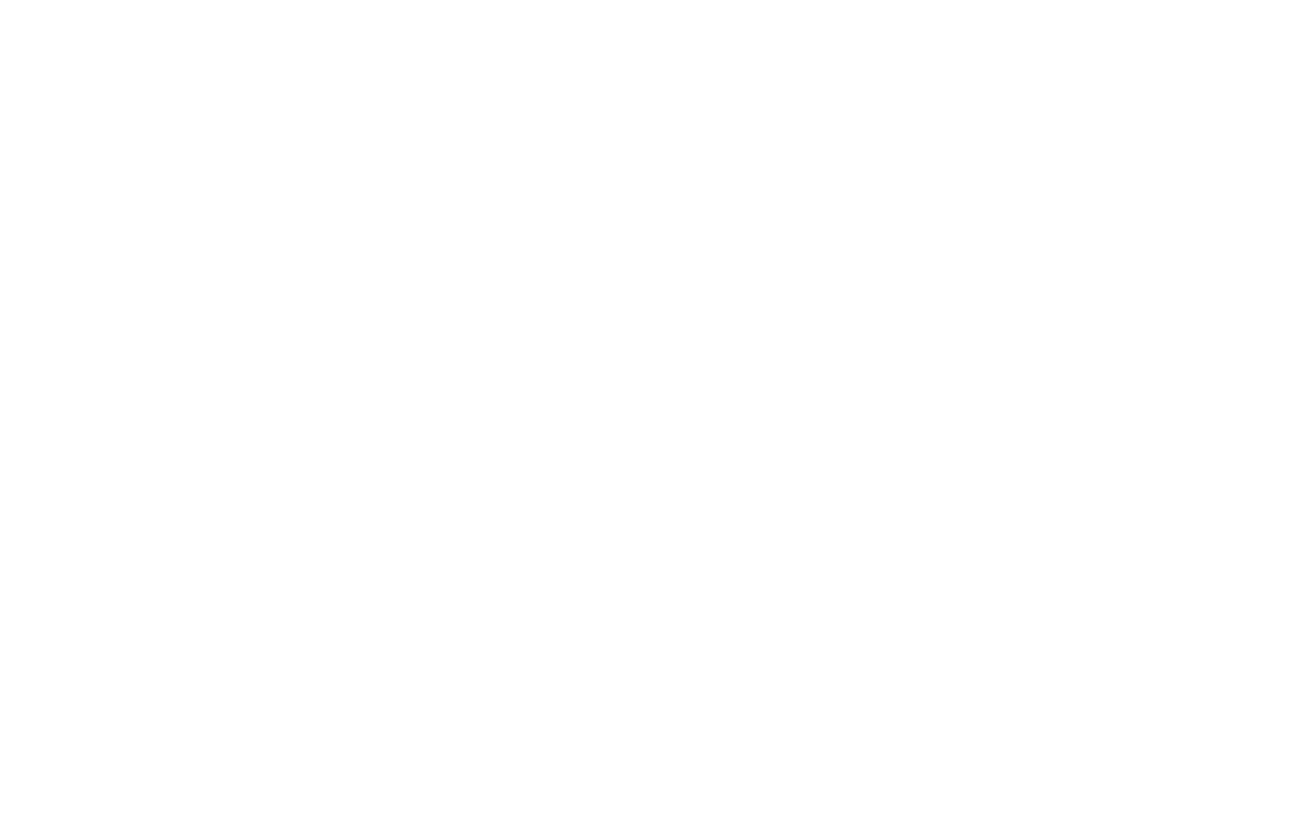
Frontiers in Pharmacology |